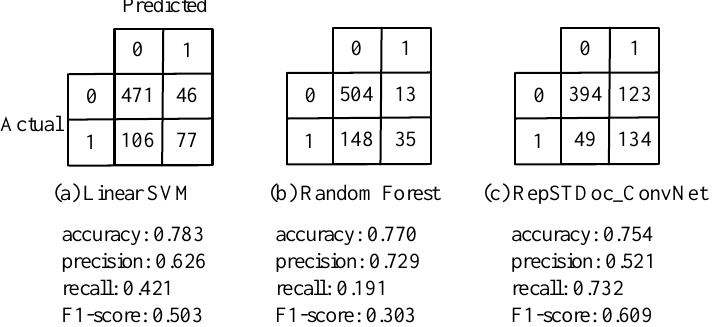
Figure 3. Comparison of confusion matrixes ( a ) Linear SVM, ( b ) Random Forest, and ( c ) Rep- STDoc_ConvNet. ‘0’ means the nonrepresentative spatio-temporal document and ‘1’ means the representative spatio-temporal document.